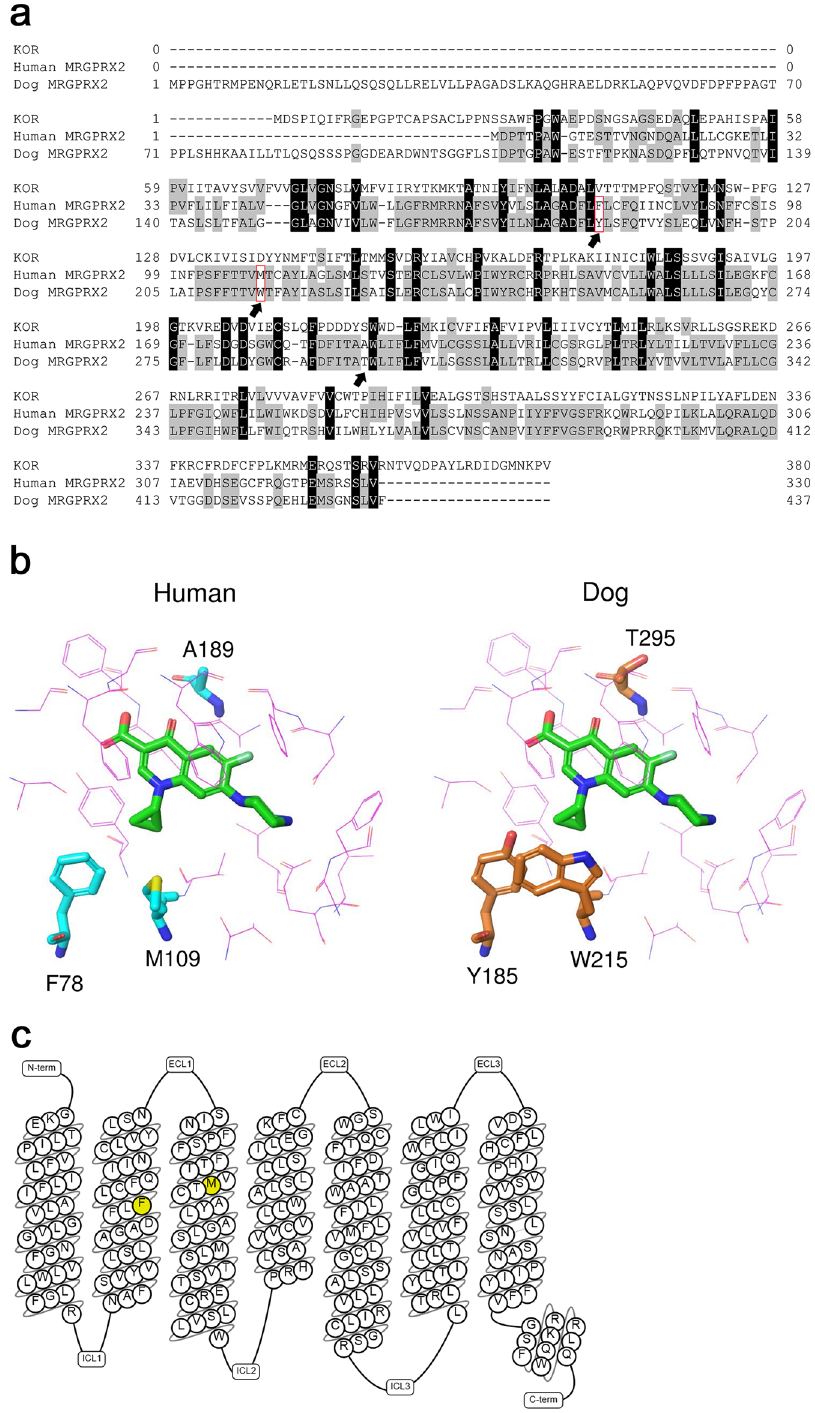
Figure 2. Comparison of human and dog MRGPRX2. ( a ) Alignment of human kappa opioid receptor (KOR), human MRGPRX2, and dog MRGPRX2. Amino acid sequence alignment was carried out using GENETYX-SV/ RC Ver.13.1.1. Arrows indicate unconserved residues between human and dog MRGPRX2 around the estimated ligand binding pocket. ( b ) Homology modeling of human and dog MRGPRX2 bound with ciprofloxacin (CPFX, green). Unconserved residues between human and dog MRGPRX2 within 5 Å around CPFX are highlighted in cyan (human) and orange (dog). ( c ) Snake diagram of human MRGPRX2. The residues at which dog-type mutations were introduced are marked in yellow. Generated using tools of